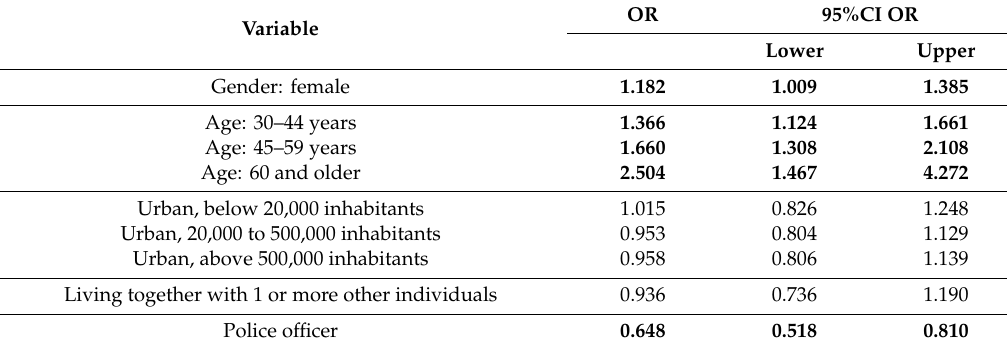
Table 2. Relationship between compliance with most preventive measures aimed at reducing the SARS-CoV-2 infection risk and selected parameters. Logistic regression